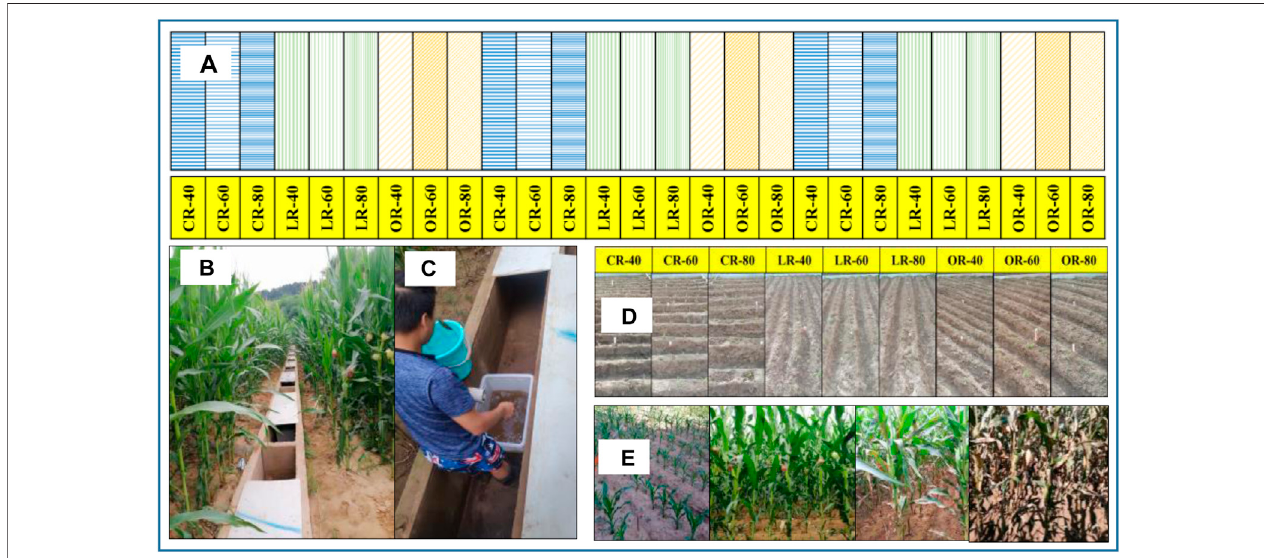
FIGURE 2 | The experimental plots and corresponding devices. (A) Experimental plots for measurement of runoff and sediment yield in different ridge tillage systems, (B) runoff and sediment collecting tray, (C) runoff and sediment collect tank, (D) ridge direction and ridge width, and (E) growth process of spring maize.